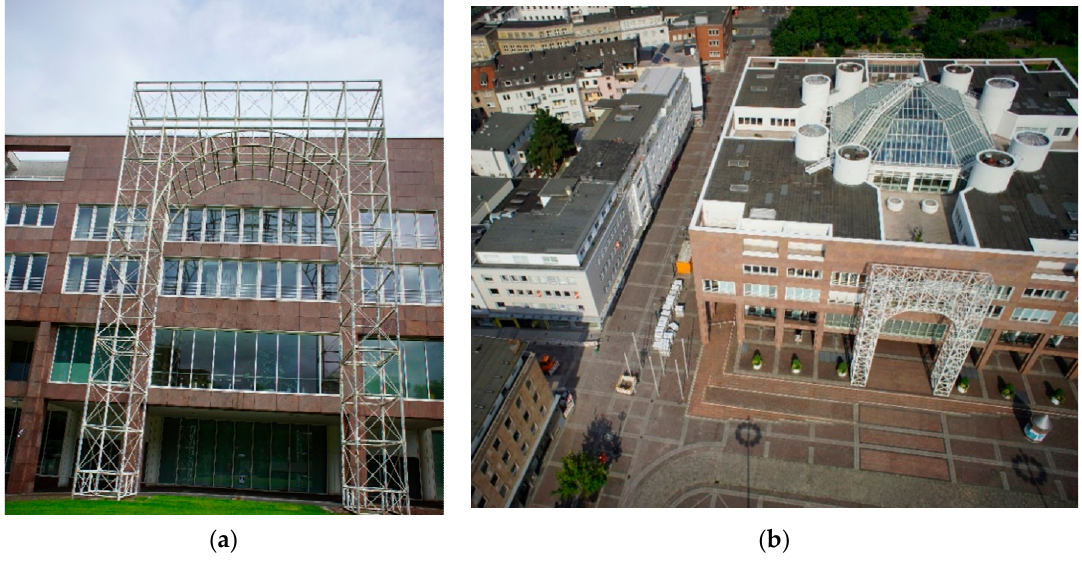
Figure 15. Some examples of the terrestrial and UAV-based subset of the Dortmund benchmark: ( a ) terrestrial image; ( b ) UAV-based image. Table 15. Median, mean and standard deviation values for the quality parameter values computed on the original (not filtered) sparse point cloud (~315,000 3D tie points).